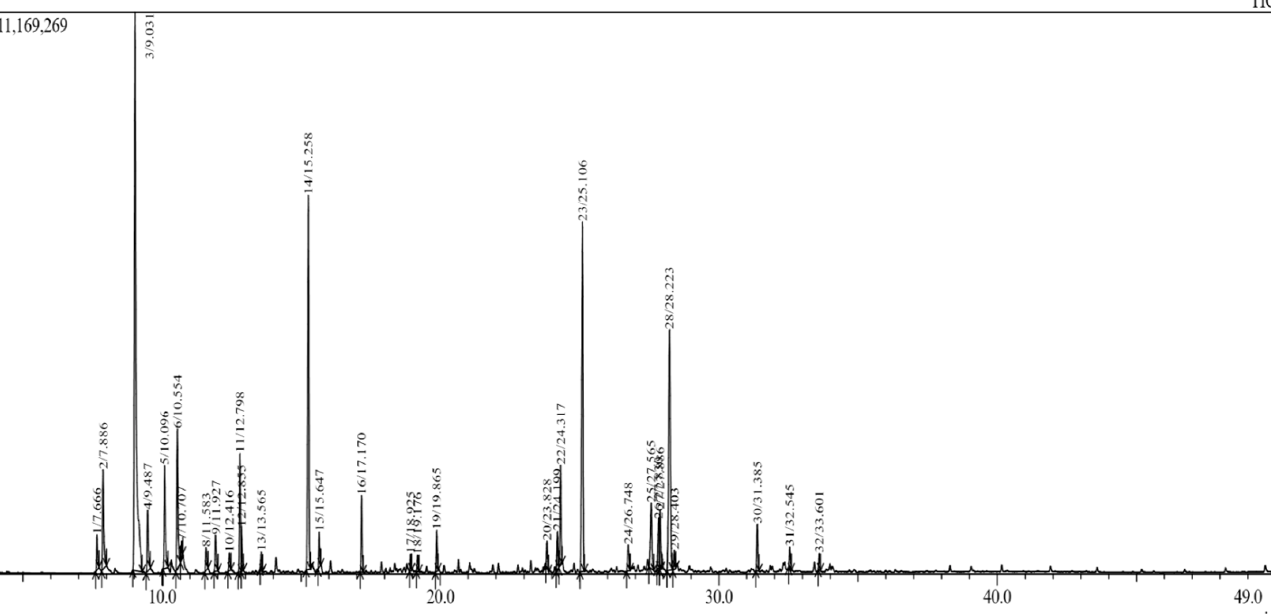
Figure 1. Chromatograph of compounds identified by GC/MS in EOs of J. thurifera . Peaks represent absolute abundances, whereas numbers on the x-axis represent retention times in min.